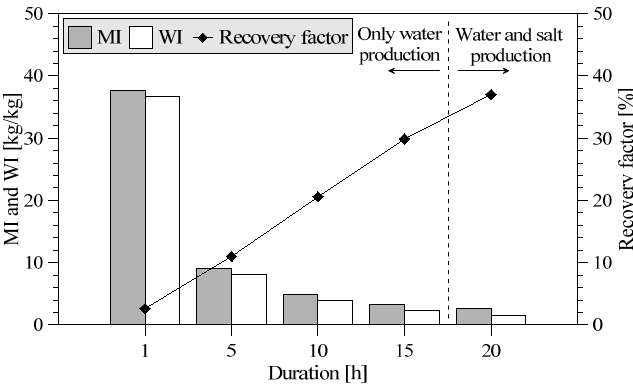
Figure 7. Mass and waste intensities and overall water recovery factor with duration of treatment.